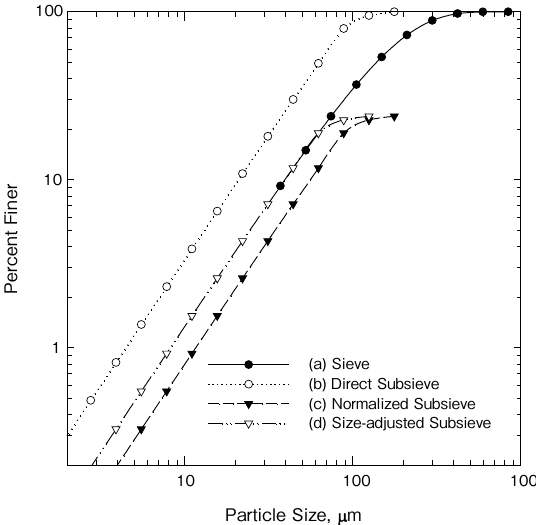
Fig. 2 Example of the combination of sieve and subsieve data to obtain an overall size distribution. Procedure: 1. Perform sieve analysis down to 400 US mesh (37 μ m) − curve (a) 2. Subsieve size analysis on -200 US mesh (74 μ m) fraction from sieving − curve (b) 3. Normalize subsieve data with respect to fraction finer than 200 US mesh in sieve analysis − curve (c) 4. Adjust size scale for normalized subsieve data to form a smooth curve with sieve data − curve (d) Curves (a) and (d) represent the complete (sieve equivalent) size distribution.